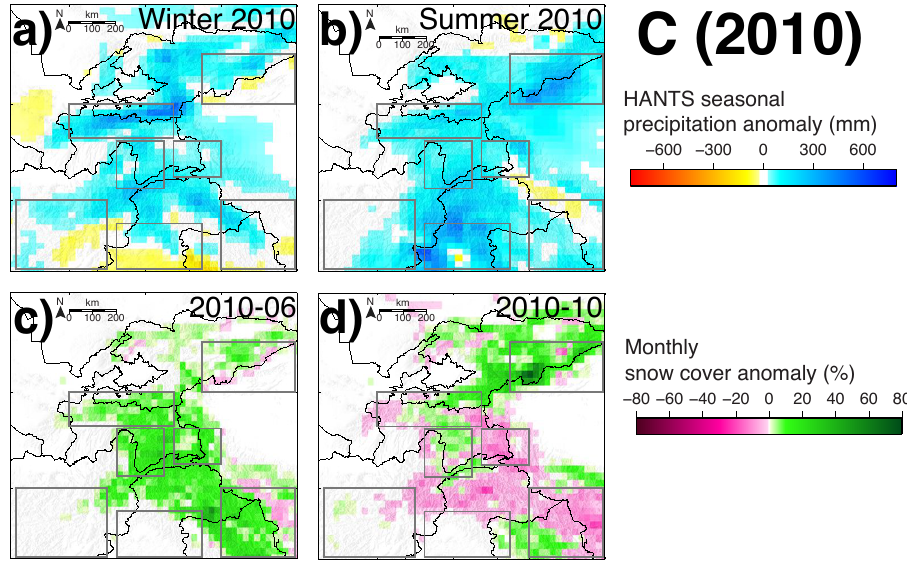
Figure 9. 2010 HANTS precipitation pattern for ( a ) winter and ( b ) summer. Strong positive summer precipitation anomalies accompanied by area-wide positive snow cover anomalies for high elevation sites in ( c ) June 2010. Diminution of snow cover except for TS until ( d ) the end of